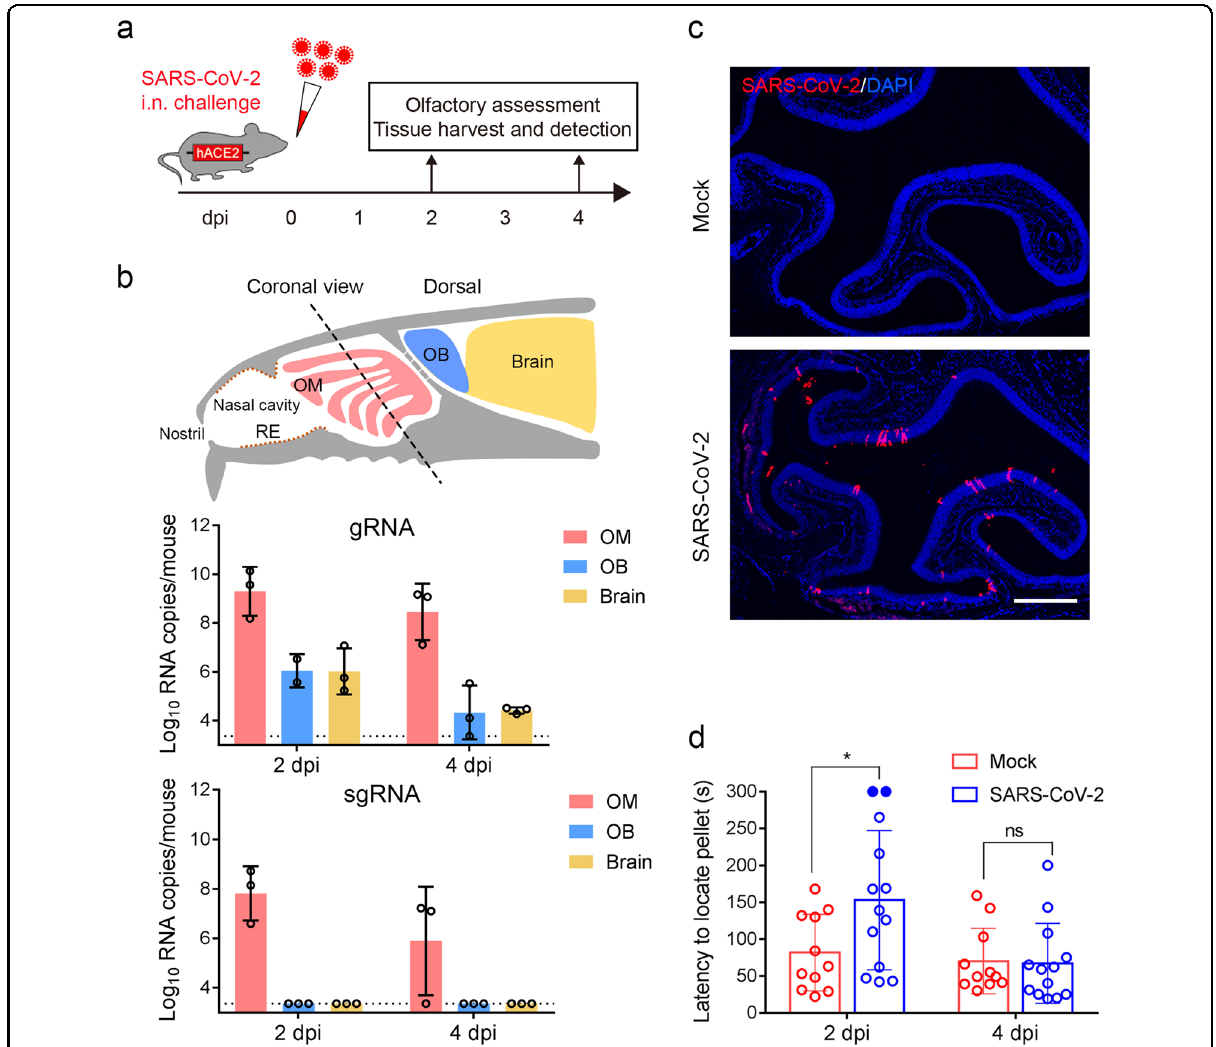
Fig. 1 SARS-CoV-2 primarily infects the OE and causes olfactory dysfunction in hACE2 mice. a Schematic diagram of the experimental design. Brie fl y, groups of 6 – 8-week-old hACE2 mice were infected with 5.4 × 10 5 PFU of SARS-CoV-2 intranasally. The olfactory function of infected mice was measured by the buried food pellet test at the indicated times post inoculation. Mice were sacri fi ced at 2 dpi and 4 dpi for viral detection and histopathological analysis. b Schematic view of the OM in the nasal cavity of mice in a sagittal plane. The dotted line indicates a coronal section (upper). Viral genomic RNA (gRNA, middle) and subgenomic RNA (sgRNA, lower) copies were determined by quantitative real-time reverse transcription PCR (qRT-PCR) and are shown as means ± SD from three independent replicates. c Immunostaining of the OM from SARS-CoV-2- infected mice for SARS-CoV-2 N protein (red) and DAPI (blue) at 2 dpi. Scale bar, 400 μ m. d Buried food pellet test. The latency to locate the food pellets for mice infected with SARS-CoV-2 ( n = 13) or DMEM ( n = 11) was measured at 2 dpi and 4